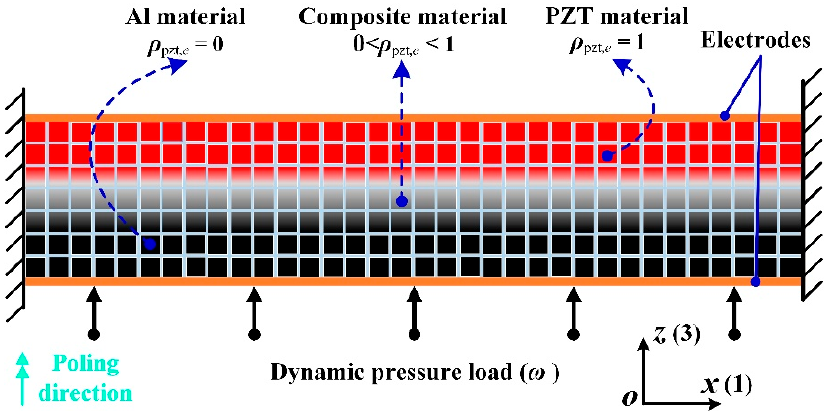
Figure 1. Schematic representation of a clamped–clamped piezoelectric energy harvesting structure.